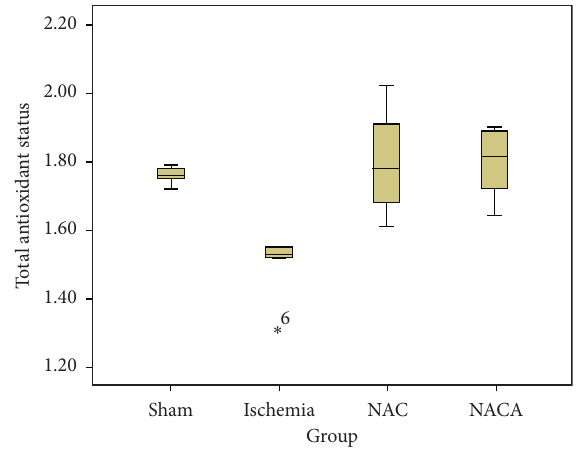
Figure 3: Box plot chart of